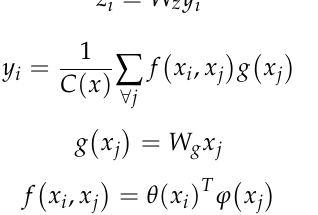
Table 2. Comparison of the calculation amount and parameter amount between the self-attention module and the typical attention modules. The input data dimension is 16 * 128 * 4 * 1 (B × C × W × H), and the parameter amount and calculation amount of the three attention modules are calculated, respectively (r in Figure 4a is taken as 4).